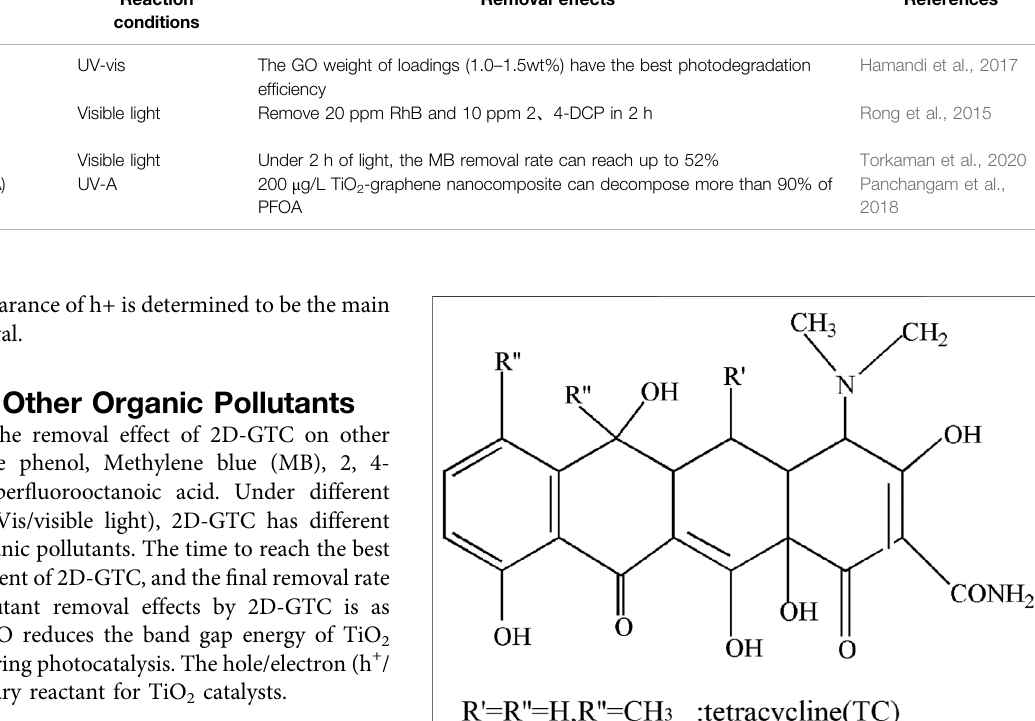
2 during photocatalysis to